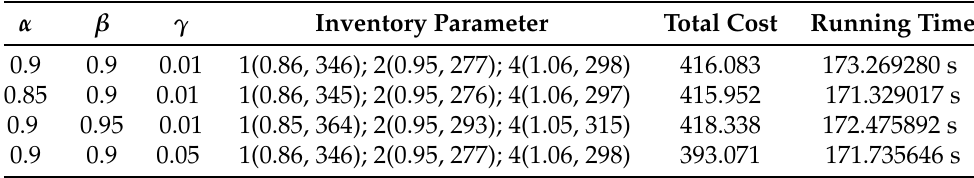
Table 7. Extensive case